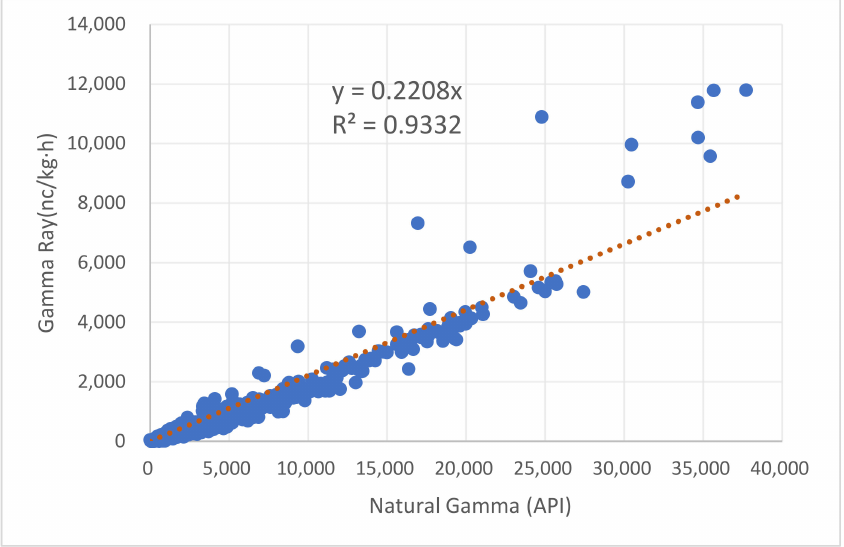
Figure 9. The correlations between the natural gamma and the gamma ray in Tarangaole